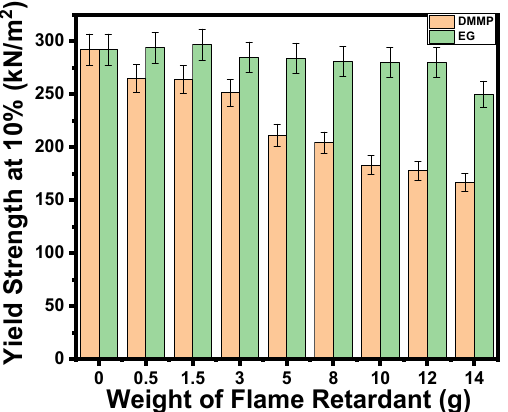
Figure 4. Graph showing the yield strength of the foams.